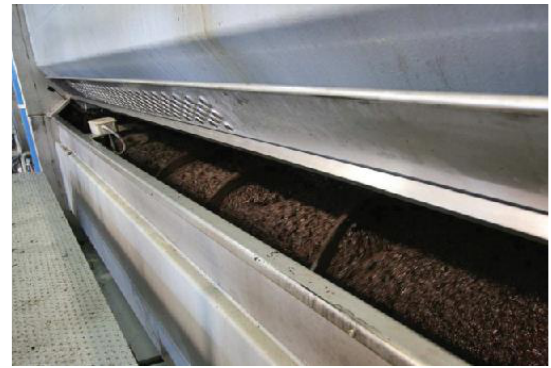
Figure 1. Industrial thermomixer in the virgin olive production process [7].